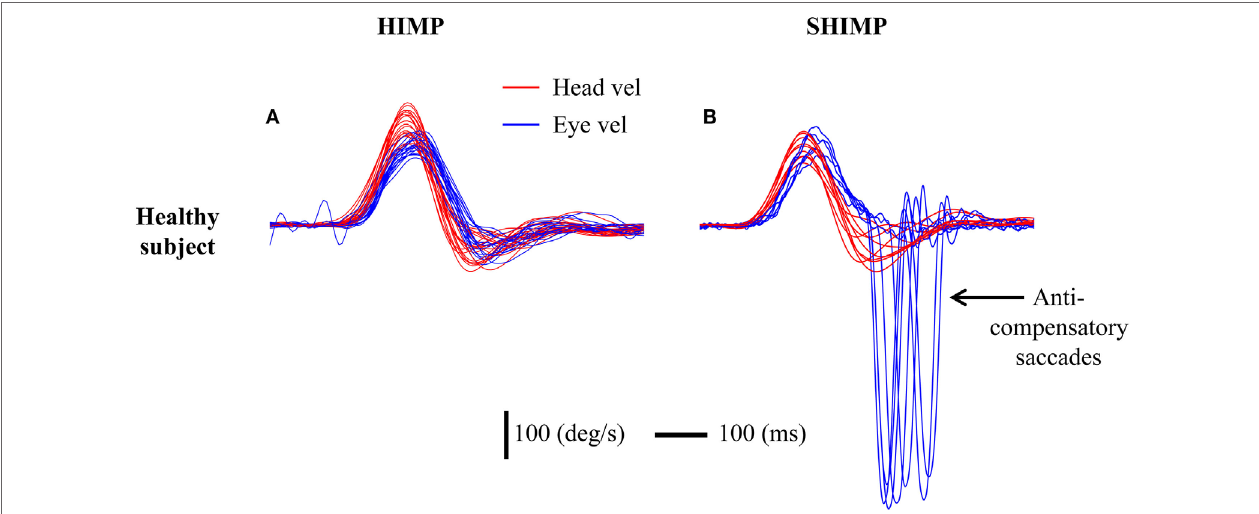
FigUre 2 | Typical responses in head impulse test (HIMP) and SHIMP procedures in a healthy subject. The figure shows superimposed eye (blue) and head (red) velocity traces for many trials. The subject shows high vestibulo-ocular reflex (VOR) slope gain in both HIMPs and SHIMPs (gains close to 1.0). (a) During HIMPs, there are no compensatory saccades. (B) In SHIMPs, although the VOR gain was close to 1.0, the subject made no covert saccades but made large anti- compensatory saccades on every trial in order to regain the target. In this and the following figures, the conventions are eye velocity is inverted to facilitate comparison with the head velocity. Red curve: head velocity; blue curve: eye velocity; vertical bar: 100°/s; horizontal bar: 100